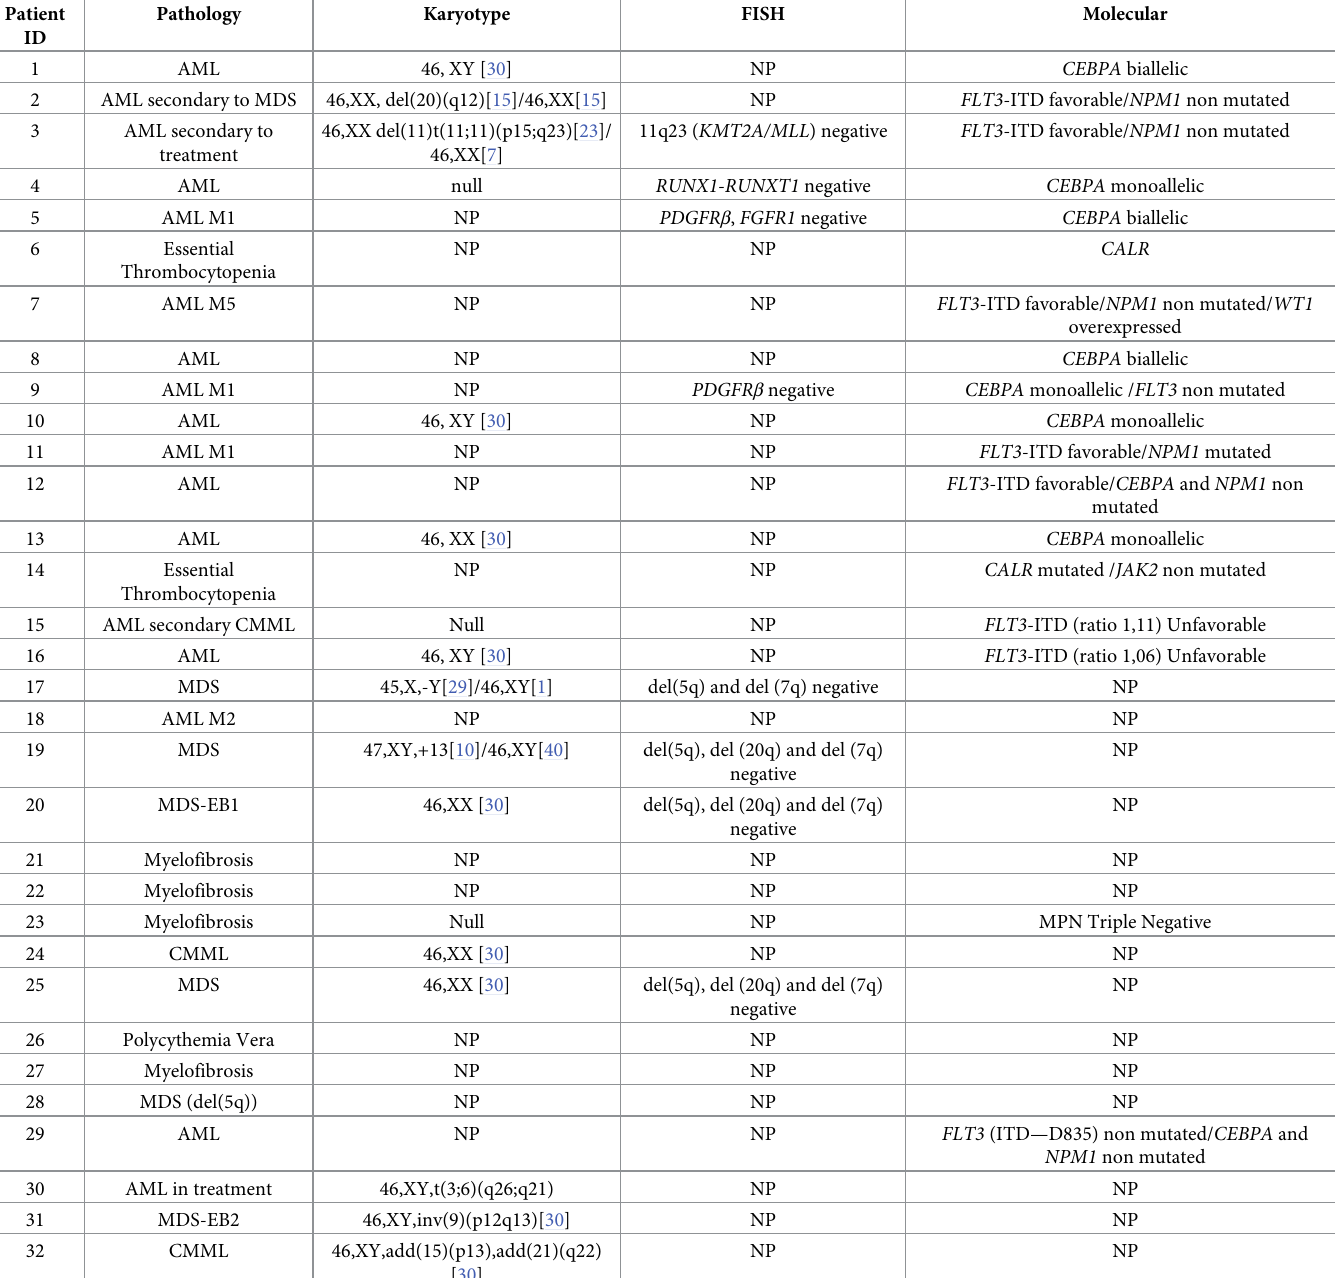
Table 1. Conventional molecular testing data of patients included in the